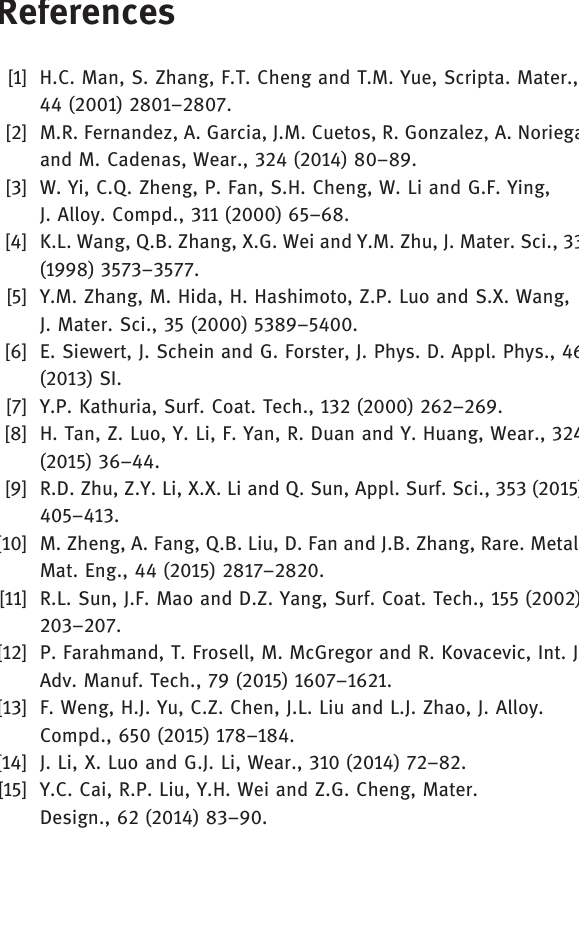
Figure 11: Worn surface morphologies of the composite coating: (a) 0%; (b) 2%; (c) 4% and (d)